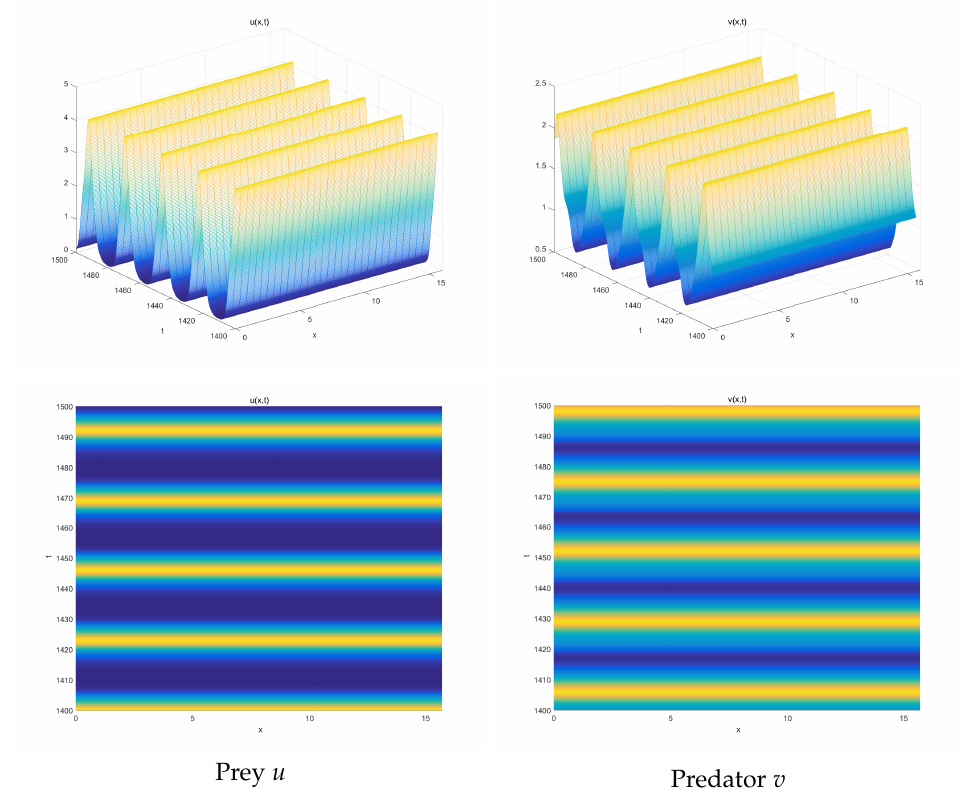
Figure 2. The numerical simulations of system (3) with τ = 1.3 and other parameters is given by (51). Thus, the direction of Hopf bifurcation is forward because µ 2 > 0. There exists the locally asymptotically stable bifurcating periodic solutions whose period is increasing (see Figure 4). At this moment, τ = 1.5, bifurcating periodic solutions with period-2